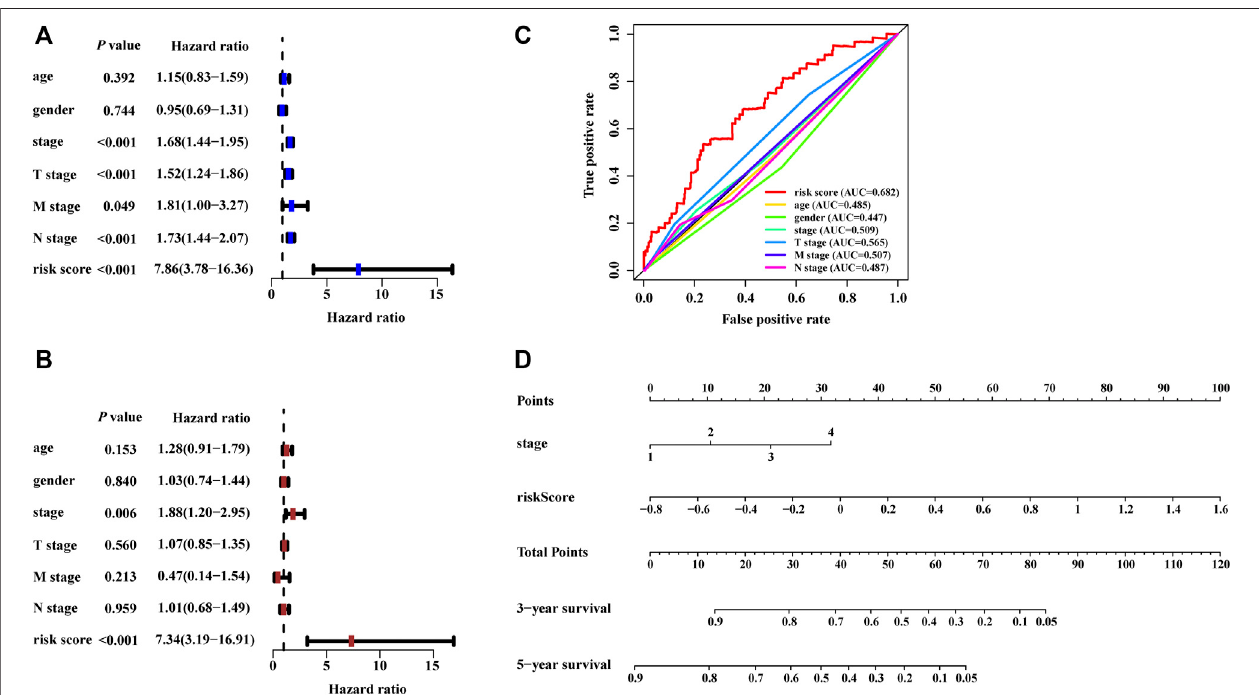
FIGURE 5 | Development of the nomogram based on the risk scores calculated from the signature. (A,B) The predictors extracted by univariate and multivariate Coxanalyses. (C) Time-dependentROCcurvesforpredictingoverallsurvivalat1 yearbyriskscore,age,gender,stage,Tstage,Mstage,andNstage. (D) Aprognostic nomogram was developed to predict the 3- and 5-year survival for LUAD